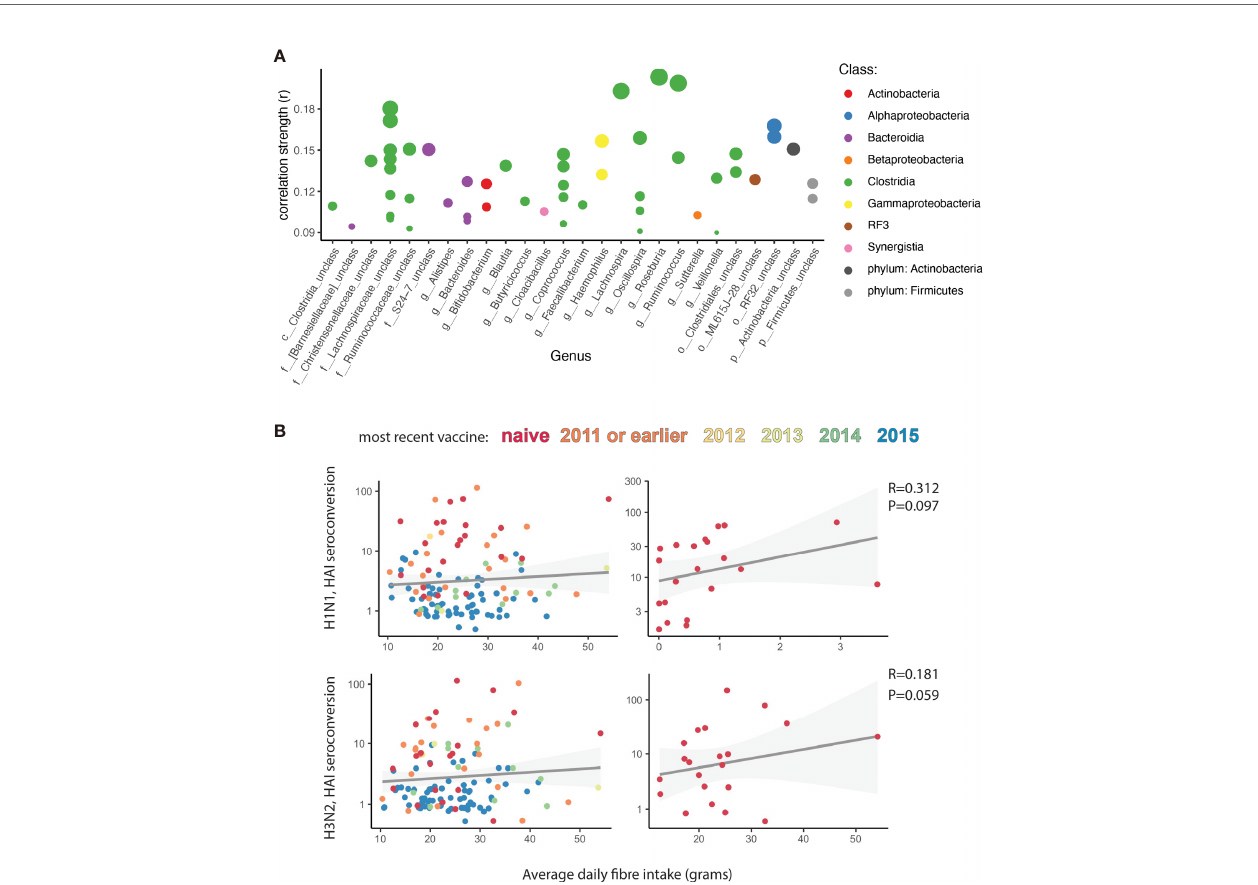
FIGURE 3 | Fiber intake correlates with in fl uenza vaccine responses. (A) Correlation analysis showing strength of Spearman correlation of operational taxonomic units (OTUs) with average dietary fi bre intake. Each point is one OTU. Colour of each point represents the class level taxonomic assignment of each OTU. OTUs are organized (x-axis) by genus, or lowest level of taxonomic hierarchy determined. Size of each point corresponds to -log (P value). Only OTUs with an adjusted P value < 0.05 are shown. (B) Correlation analysis of average dietary fi bre intake with Hemagglutinin (HAI) seroconversion. Colour represents the number of self- reported seasonal in fl uenza vaccinations each participant received in the last 5 years. On the left all participants are analysed. On the right only participants naïve to previous in fl uenza vaccination are analysed. Grey shadow represents 95% con fi dence